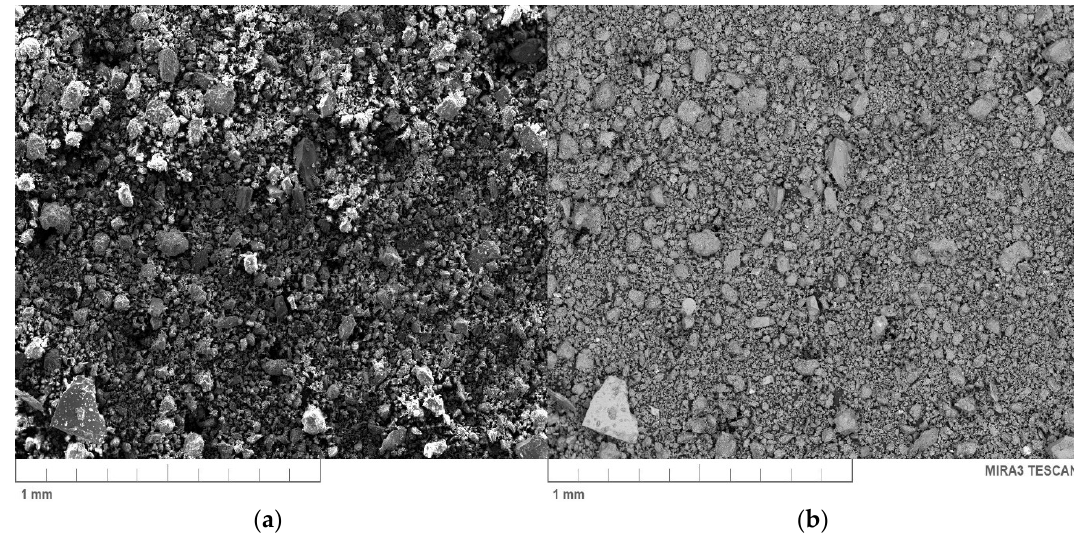
Figure 2. Scanning electron microscopy (SEM) images of a bentonite: ( a ) secondary electron (SE) and ( b ) back-scattered electron (BSE). Table 2. Chemical composition of bentonite in wt.%.